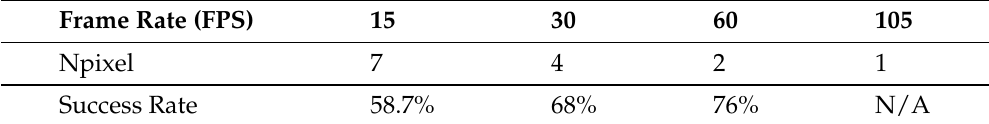
Figure 22. HR measurement error rate when participants drive on the highway recorded at 60 FPS ( left ), 30 FPS ( middle ) and 15 FPS ( right ). Table 3. Success rate and number of pixels transitioned across two consecutive frames at different frame